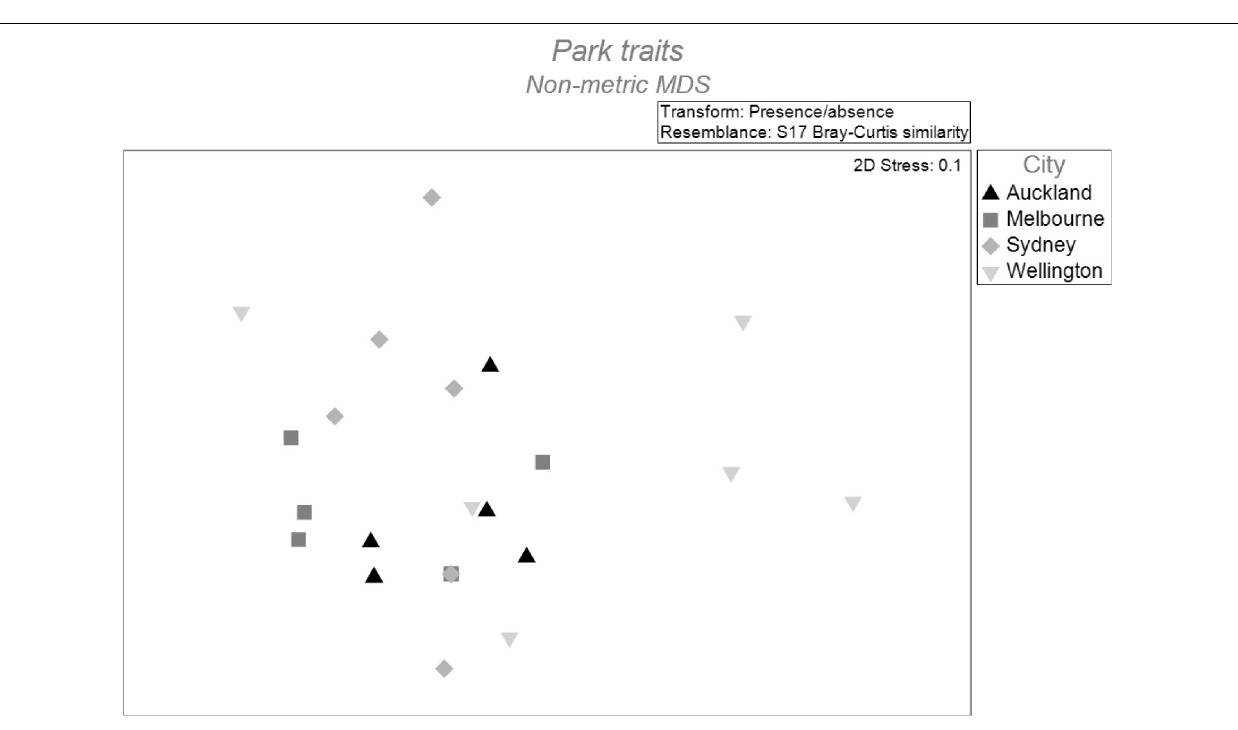
not linked with urban park use. We also asked